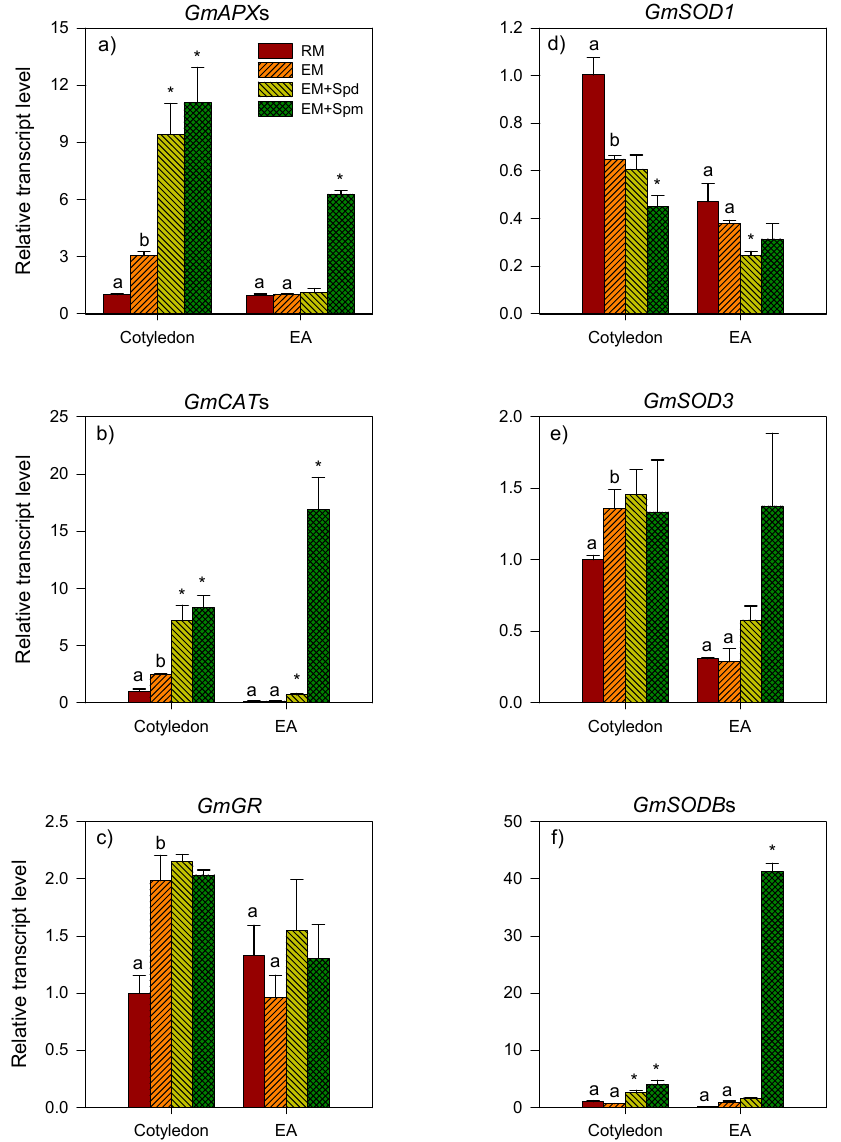
Figure 4. Expression of the genes encoding antioxidative enzymes in the tissues of 4 DAP seedlings. Relative transcript levels of GmAPX s ( a ), GmCAT s ( b ), GmGR ( c ) and the members of the GmSOD gene family, GmSOD1 ( d ), GmSOD3 ( e ) and GmSODB s ( f ) in the cotyledon and embryonic axis (EA) tissues of 4 DAP seedlings under regular watering (RM) and excess moisture (EM) conditions, with or